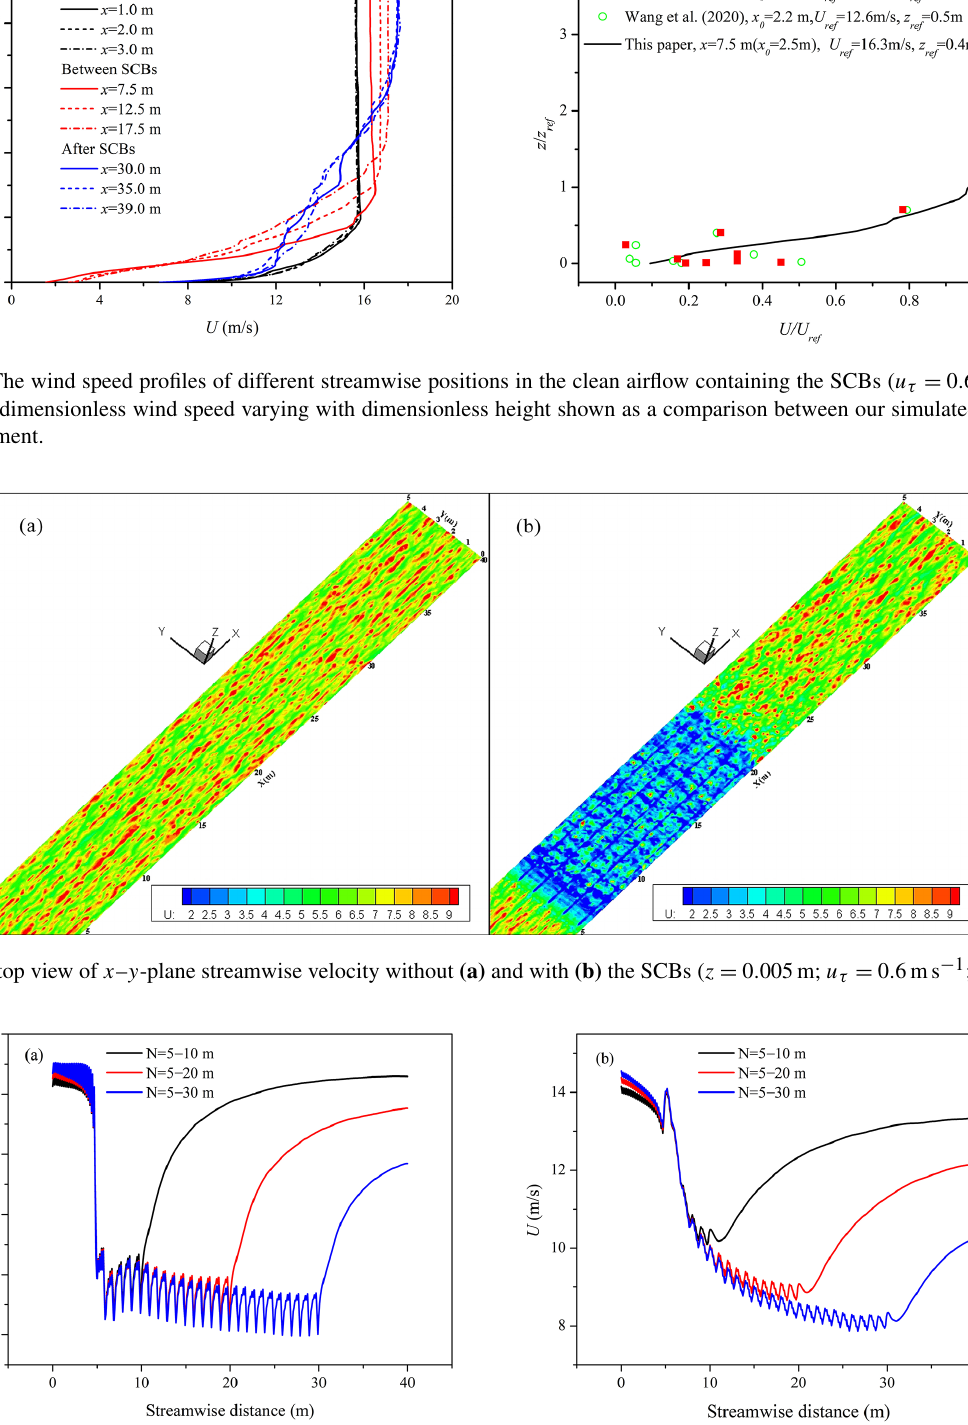
Figure 8. The streamwise wind speed in the clean airflow containing the SCBs at a height of 0.1m (a) and a height of 0.2m (b) ( u τ = 0 . 6ms − 1 ; N = 5–10, 5–20,